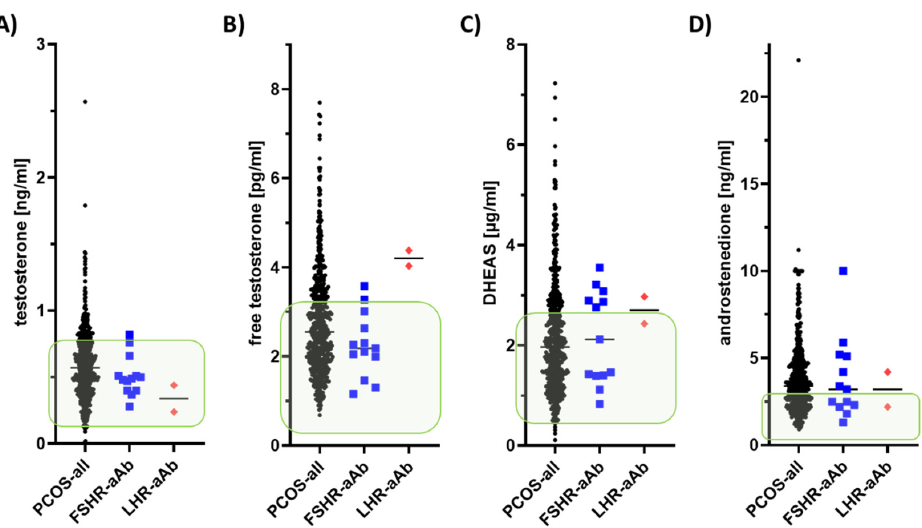
Figure 4. Comparison of steroid hormones in PCOS samples in relation to reference ranges and autoimmunity to the human FSHR or LHR. The serum samples from the PCOS patients were characterized for ( A ) total testosterone, ( B ) free testosterone, ( C ) dehydroepiandrosterone (DHEAS), and ( D ) androstenedione concentrations. The direct comparison of the full set of data from the PCOS samples (PCOS-all) to the reference ranges (indicated by green squares) and to the samples positive for autoantibodies to the human FSHR (FSHR-aAb) or LHR (LHR-aAb) is presented. No striking differences between within the groups of PCOS patients is observed, except for a seemingly elevated level of free testosterone in the two subjects positive for LHR-aAb.